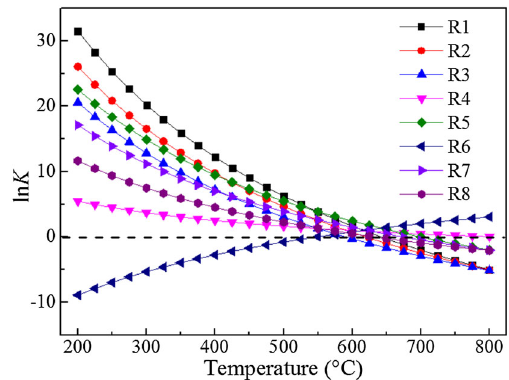
Fig. 1 Equilibrium constants of the reactions as a function of